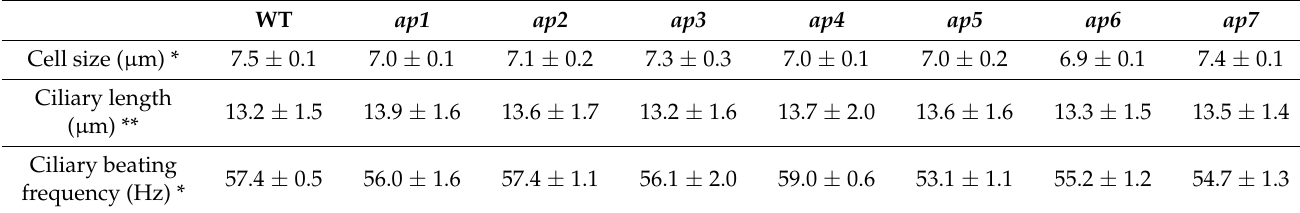
Table 1. Morphological and motility phenotypes of ap mutants.